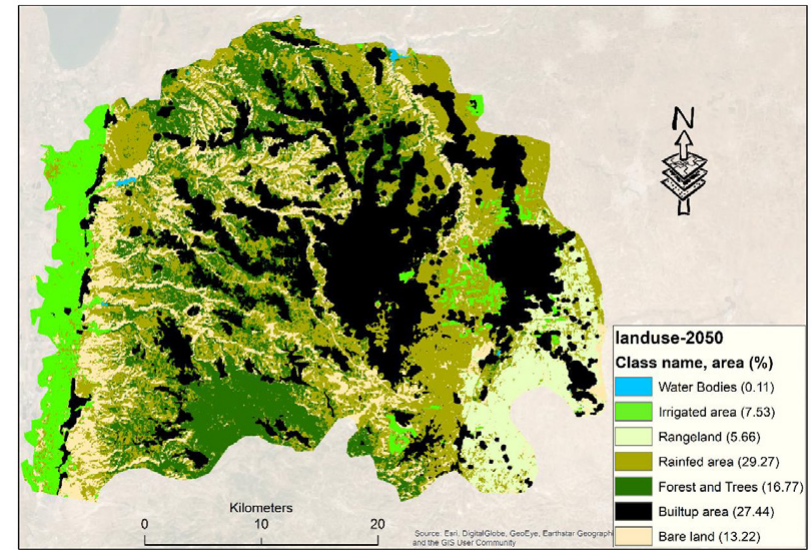
Fig. 4b: Predicted LULC changes in Irbid governorate for 2050